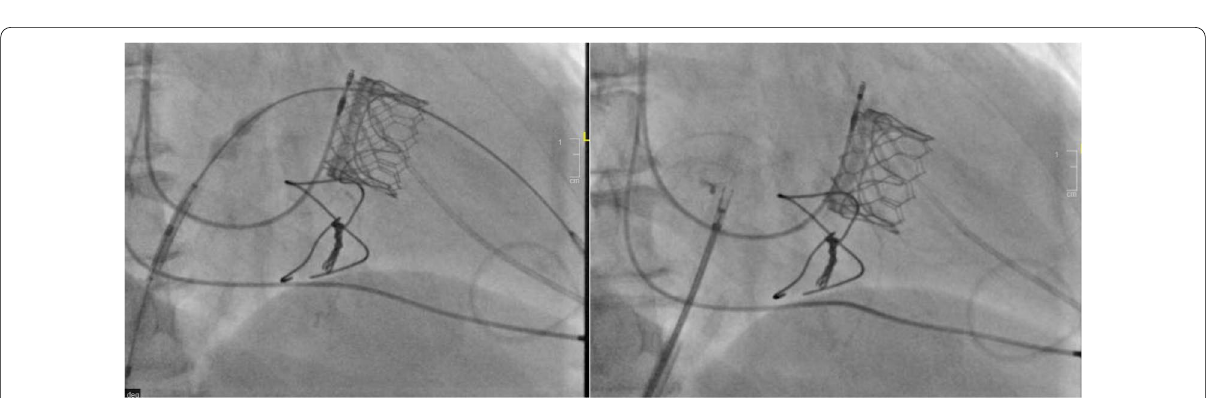
Fig. 5 (1) proper positioning of valve is curcial to avoid valve migration, (2) after successful valve implantation assessment of the iatrogenic ASD is mandatory to decide the need of ASD closure in case of hemodynamic significance as in this